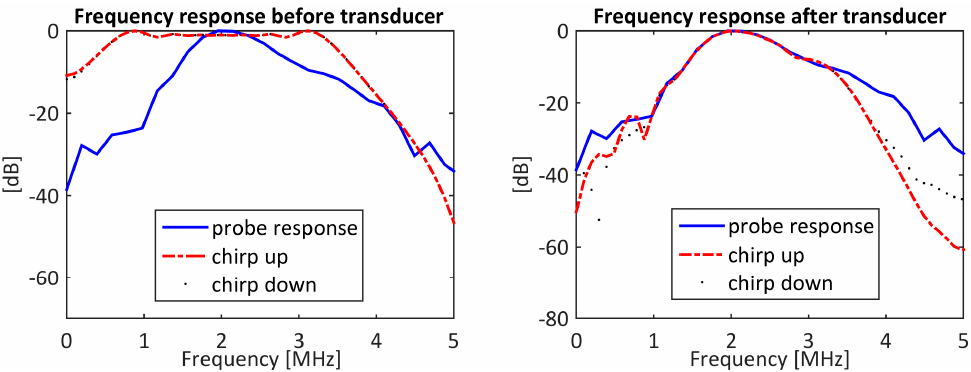
Figure 4. Frequency response of the two chirp codes.